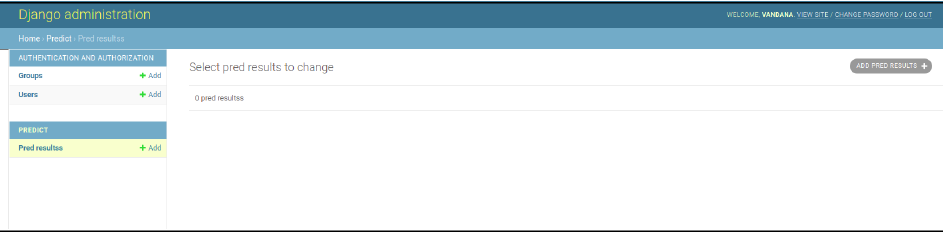
Figure 13. The table for predicted results available in the admin